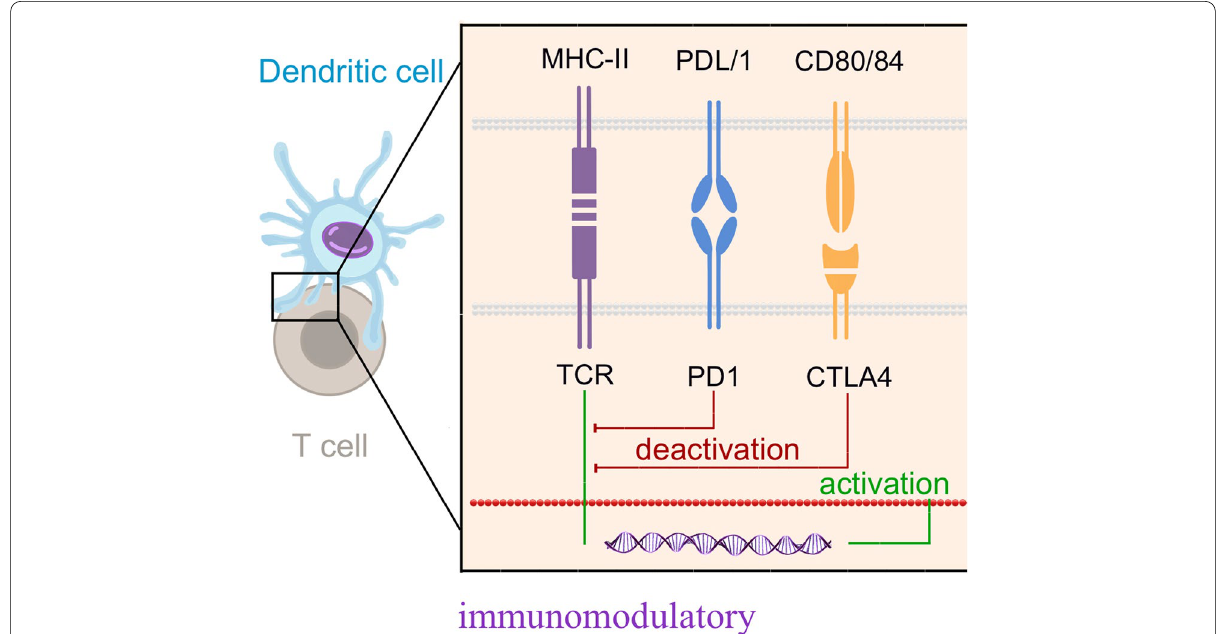
Fig. 4 Immune checkpoint inhibitors for the treatment of TNBC. Immune checkpoints limit the anti-tumor autoimmune response by inhibiting effector T lymphocytes. PD-L1 expressing in the tumor cells binds to PD-1 which is on the surface of T cell and prevents T cell activation. The tumor-infiltrating lymphocytes also can express highly PD-1, and both of them are increased in TNBC. ICIs can enhance the anti-tumor immune responses to kill tumor